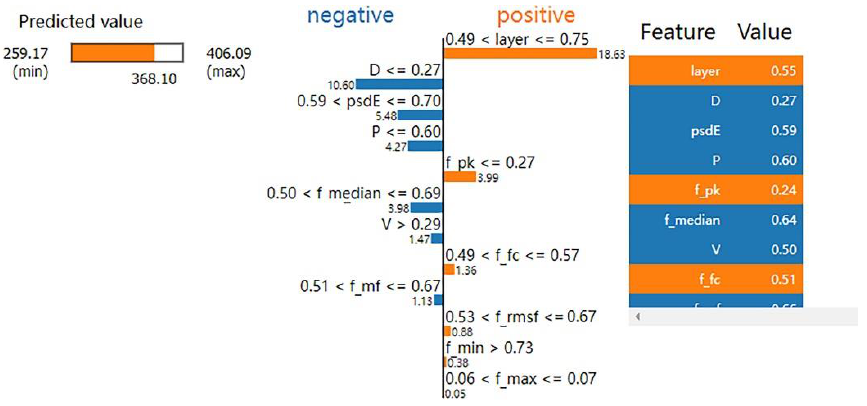
Figure 8. Infographic of data X features influencing weights.